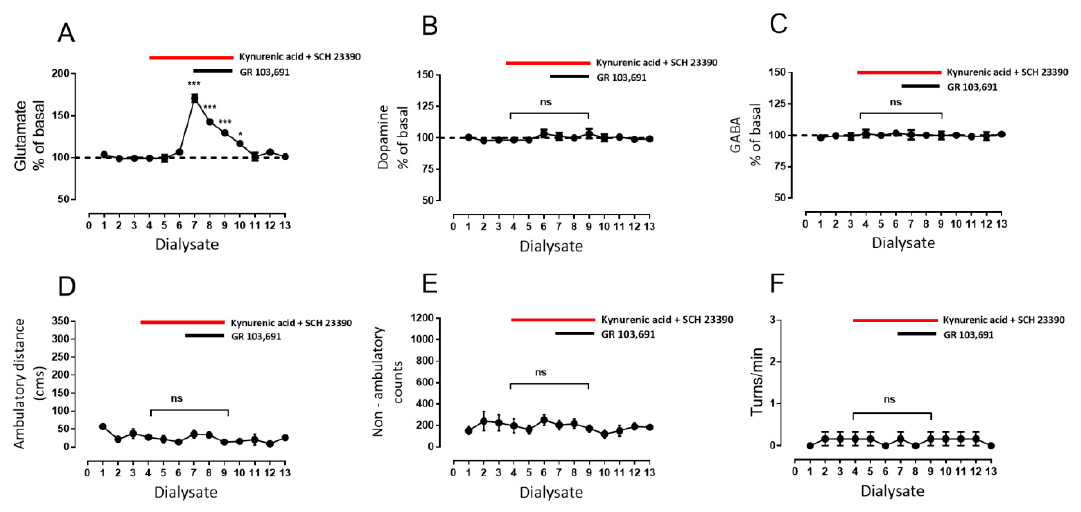
Figure 5. Concomitant blockade of NMDAR and D1R prevents increments of dopamine, GABA, and behavioral e ff ects, but not of glutamate, induced by D3R blockade. ( A – C ) illustrate the e ff ect of intra-nigral NMDAR blockade with kynurenic acid and D1R with SCH 23,390 (500 µ M and 1 µ M, respectively from dialysate three to eight) on interstitial concentration of glutamate, dopamine, and GABA, together or in co-perfusion, of D3R antagonist GR 103,691 (100 nM, from dialysate six to eight). ( D – F ) present the behavioral e ff ects of co-superfusion of the antagonists in ambulatory distance, non-ambulatory counts, and turns / min, respectively. * p < 0.05 and *** p < 0.005 with respect to dialysate six; ns, non-significant di ff erences between dialysates. Two-way ANOVA followed by Tukey, n = 6 rats.